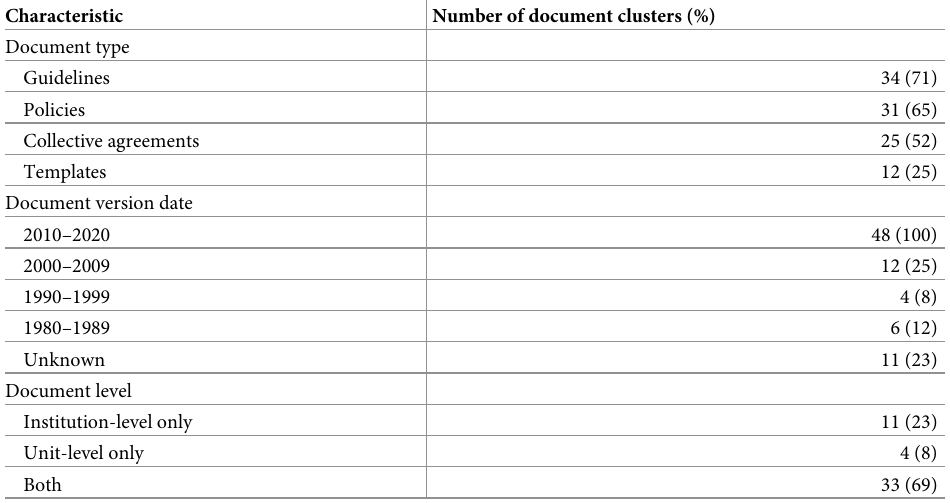
Table 2. Document cluster characteristics (n =